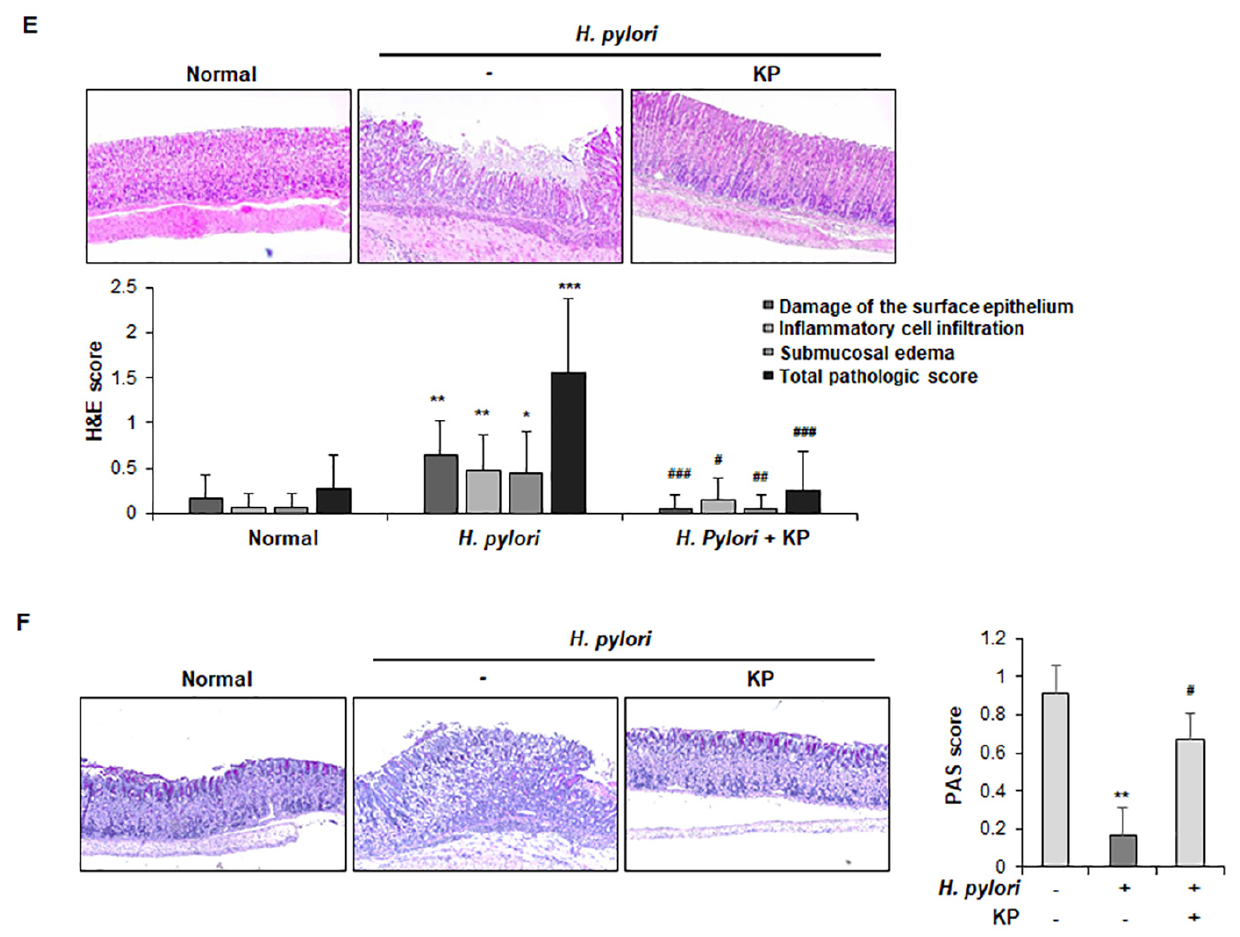
Figure 1. KP decreases the severity of H. pylori − infected gastric mucosal injury in mice. ( A ) Diagram shows the experimental design of H. pylori -infected gastric mucosal injury mice model. ( B ) Result of H. pylori IgG levels in mice using serum obtained from each group (n = 8). ( C ) Results of the CLO test in mice using gastric mucosal tissue from each group (n = 8, positive reaction shown by change in color from yellow to purple). ( D ) Representative images of the stomach and gastric mucosal injury index (n = 8). ( E ) Paraffin sections of stomach were stained with hematoxylin and eosin (H&E, magnification, × 100). Damage to the surface epithelium, inflammatory cell infiltration, submucosal edema and total pathological score in each group ( n = 8) were quantified from H&E − stained sections. ( F ) Detection of mucous production was performed by PAS staining in each group ( n = 3). Representative images of gastric sections were stained with PAS (magnification, × 100). Detection of mucous production were immunostained with PAS in mice gastric mucosal (positive result depicted by purple color), and one of three representative experiments is presented ( × 100). Graph shows the number of PAS- positive cells from at least 10 fields (bottom). Data are the mean ± standard deviation. Statistical group; # p < 0.05, ## p < 0.01 and ### p < 0.001 vs. H. pylori group, significantly different